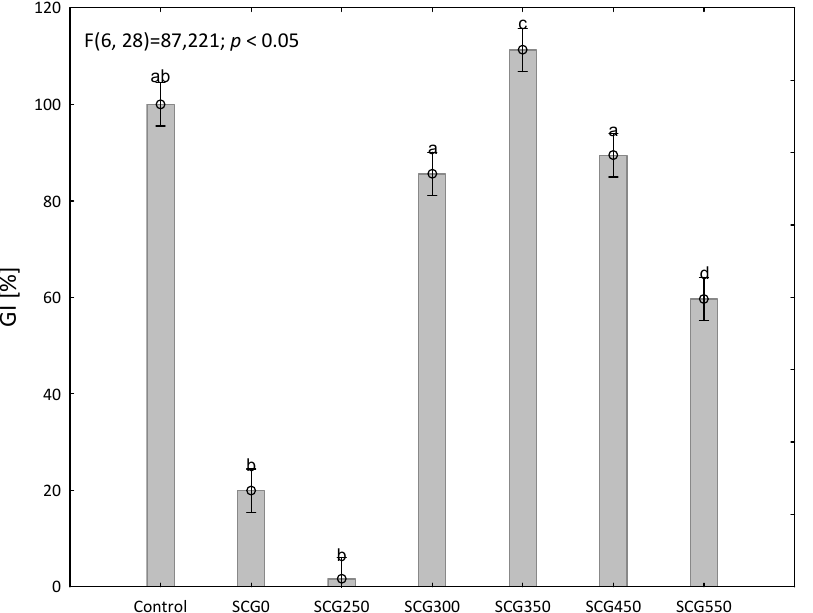
Figure 8. Phytotoxicity effect of SCG aqueous extracts on the germination of Lepidium sativum L. seeds after 48 h. Data are expressed as means of five independent bioassays (five replicates for each concentration (aqueous extracts) per bioassay) ± SE. Different letters (a–d) indicate significant differences between treatment effects when compared to the control (ANOVA, Tukey test, p < 0.05).